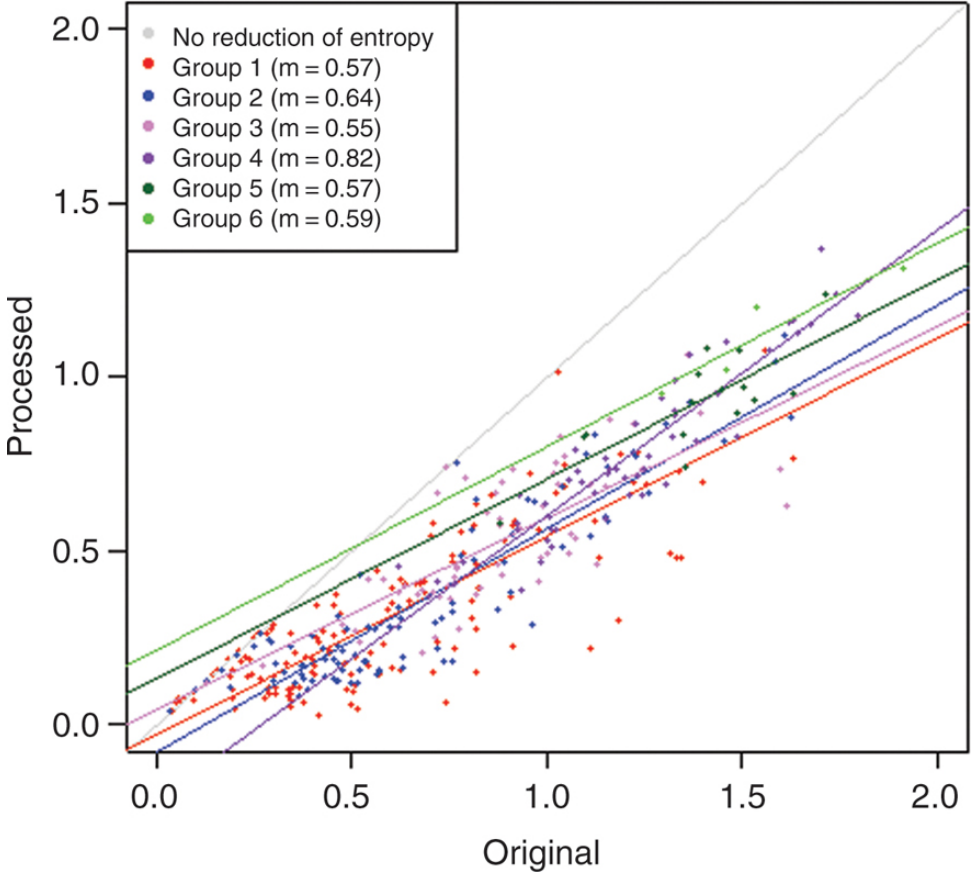
Figure 2: Comparison of S () for original and processed alignments. Each data point represents one miRNA family. Data are stratified into six groups of miRBase families depending on the number of members in the initial alignment (1: 2-10 pre-miRNAs, 139 families; 2: 11-20 pre-miRNAs, 92 families; 3: 21-40 pre-miRNAs, 57 families; 4: 41-100 pre-miRNAs, 52 families; 5: 101-200 pre-miRNAs, 15 families; 6: >200 pre-miRNAs, 4 families, indicating that the improvements in align- ment quality depends much more strongly on the entropy of the input alignment than on the number of sequences in the miRNA